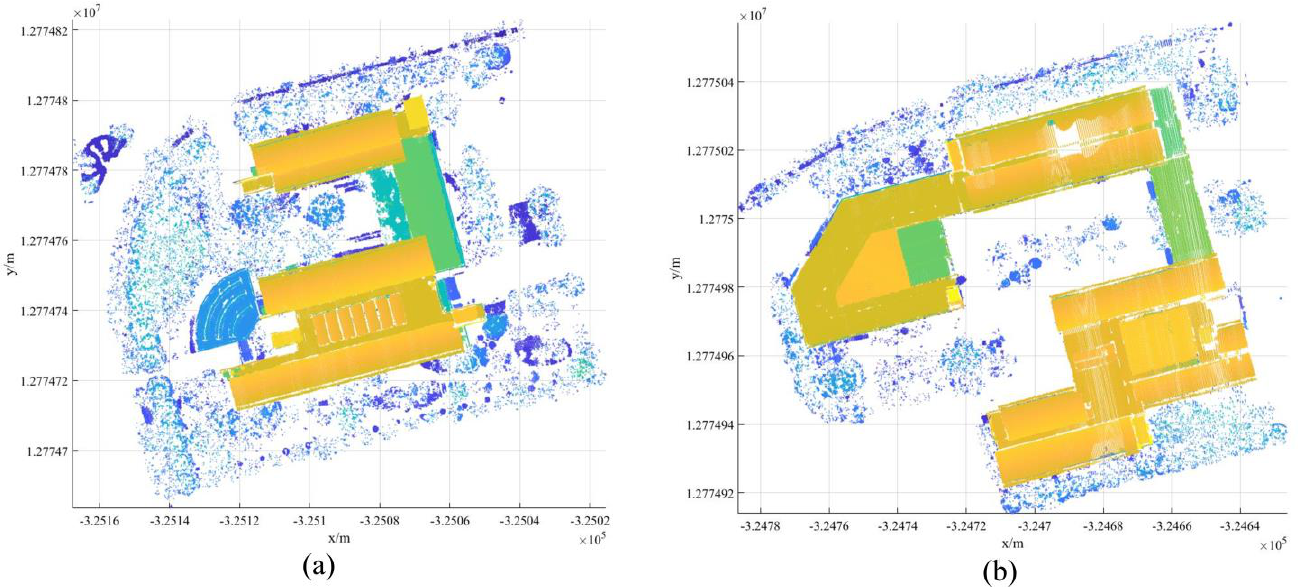
Figure 8. Building point cloud extracted results based on plane feature extraction. ( a ) Plot 1; ( b ) Plot 2.